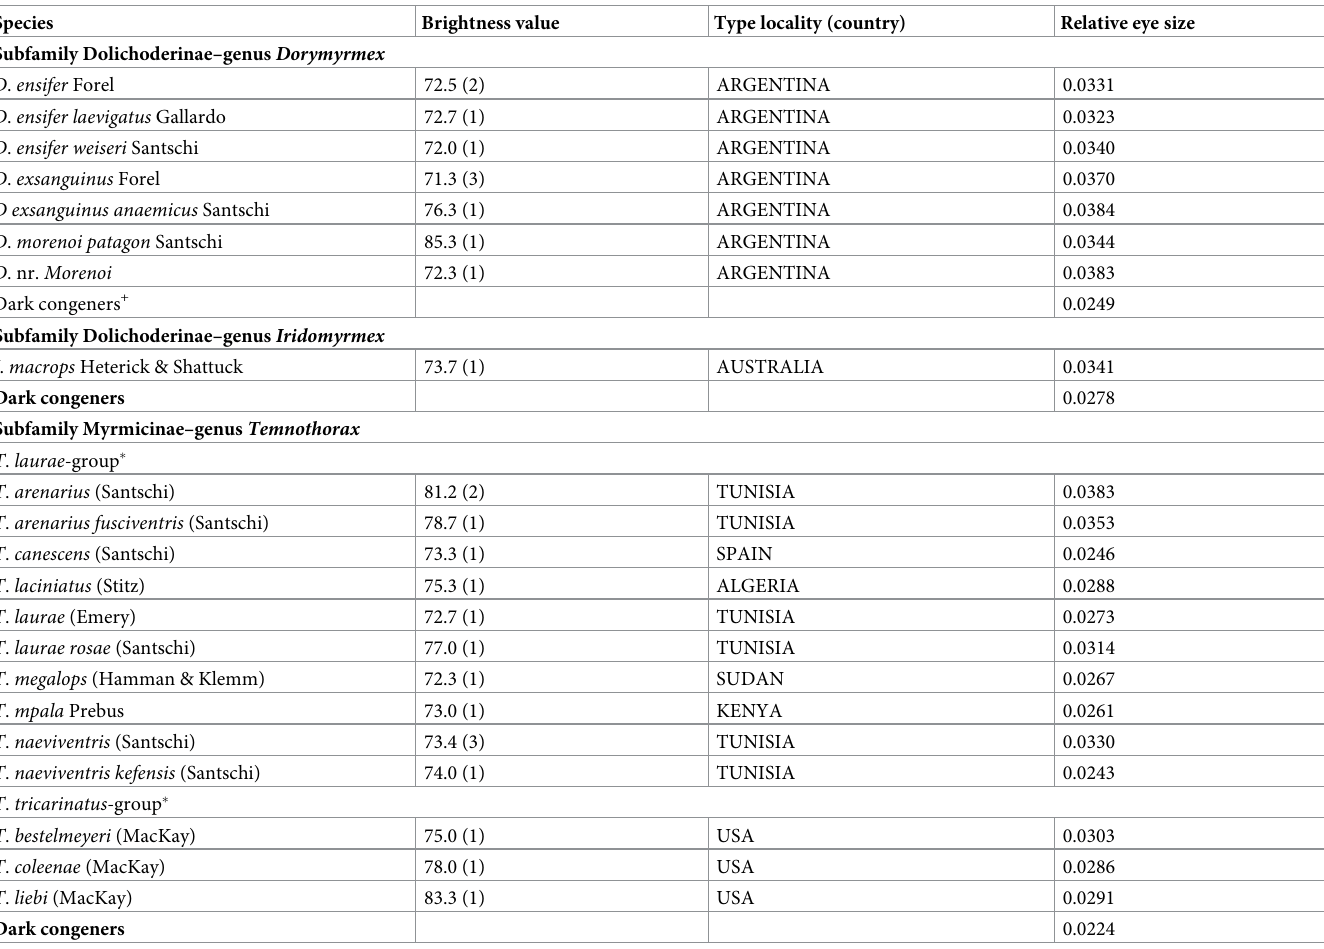
Table 5. Additional pale ant species (see text) with enlarged eyes based on photographs examined on Antweb (www.antweb.org). Species are listed alphabetically by subfamily, genus, species group, species, and subspecies. High resolution photographs of each species can be viewed by going to https://www.antweb.org/advSearch.do, then placing the genus and species name in the advanced search box. Brightness values are given as mean ( n ) (see text). Relative eye size was calculated as eye area/meso- soma length.